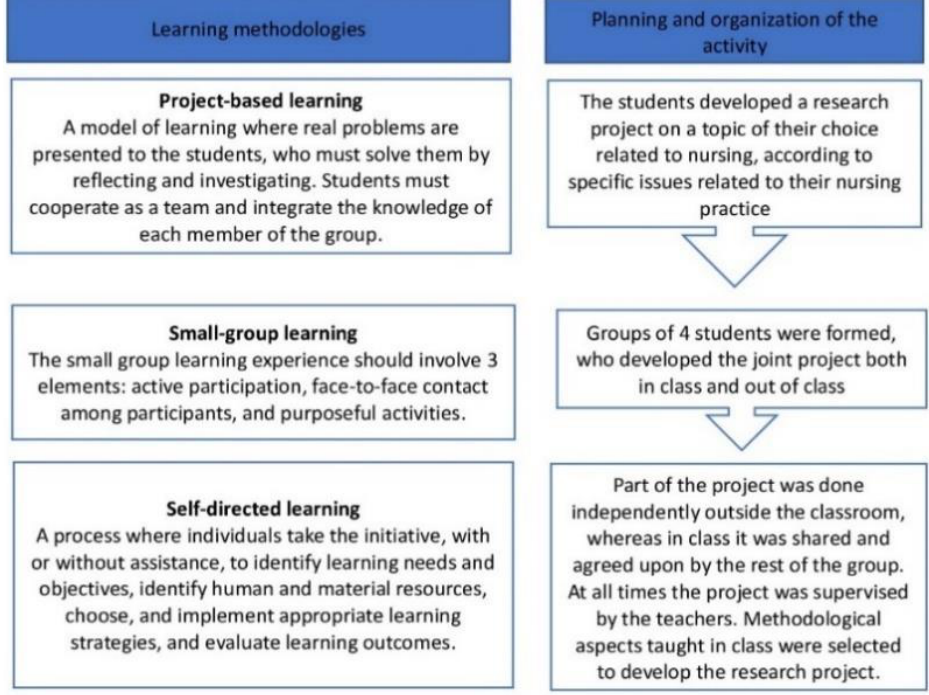
Figure 1. Education innovation proposal.